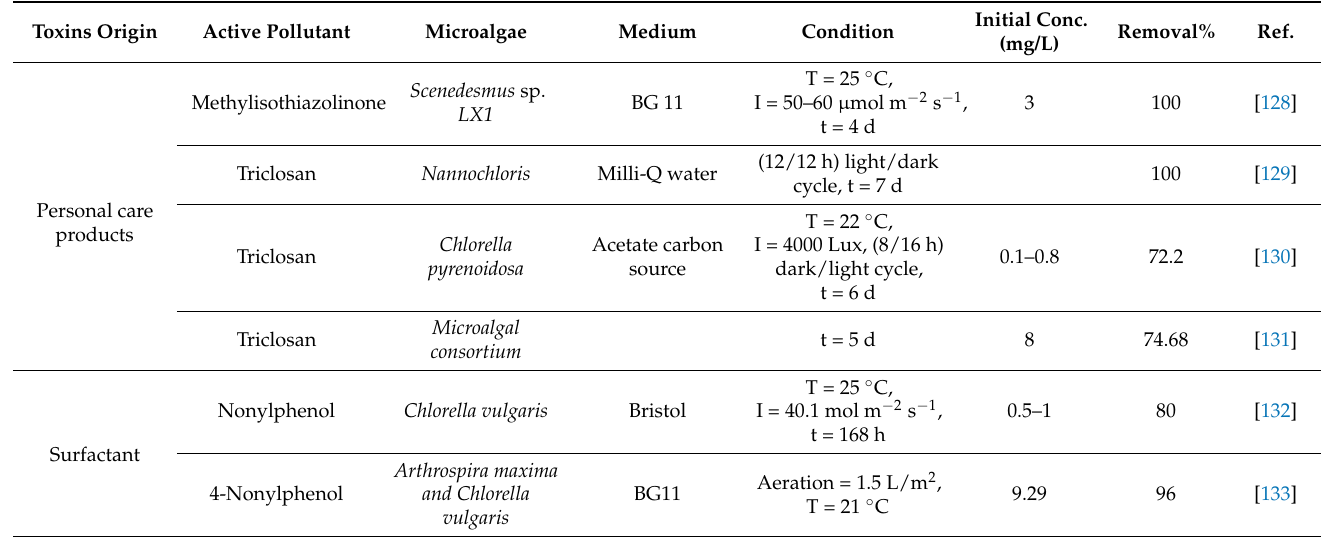
Table 7. Non-pharmaceutical emerging pollutant removal using